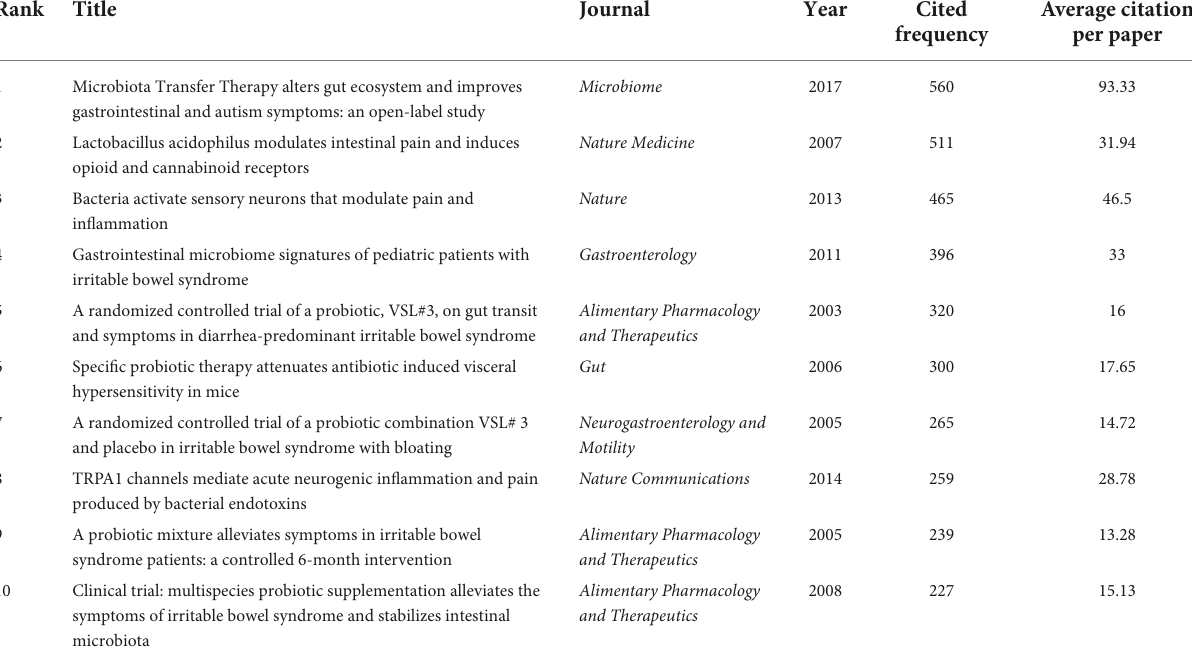
TABLE 2 The top 10 cited articles in the included 233 articles about the relationship between the gut microbiota and pain.